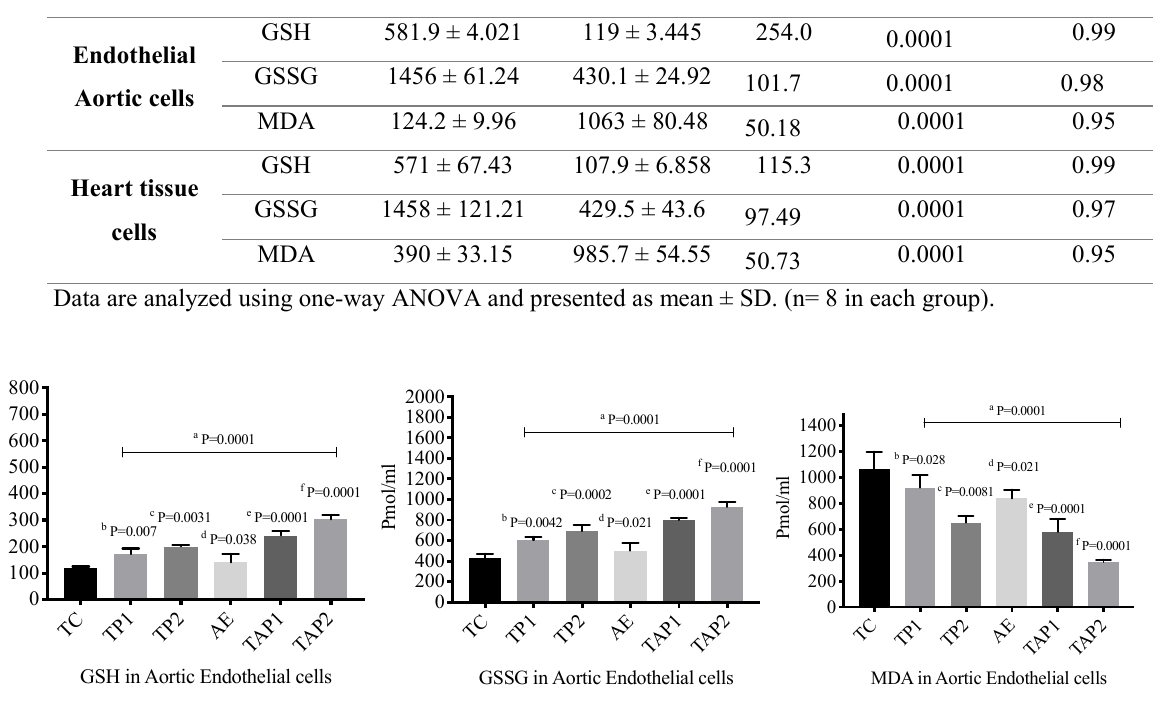
Figure 1. Aortic endothelial cells GSH, GSSG and MDA concentration in different groups. Each group is consisted of 8 rats and data are expressed as mean ± SD. a Significant effect of Pumpkin (PKs) extract and